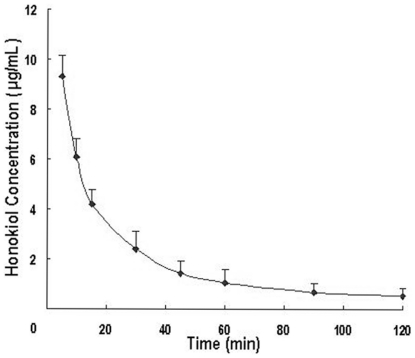
Mean plasma concentration-time curve of honokiol in rat plasma (The data from 0 min was omitted).